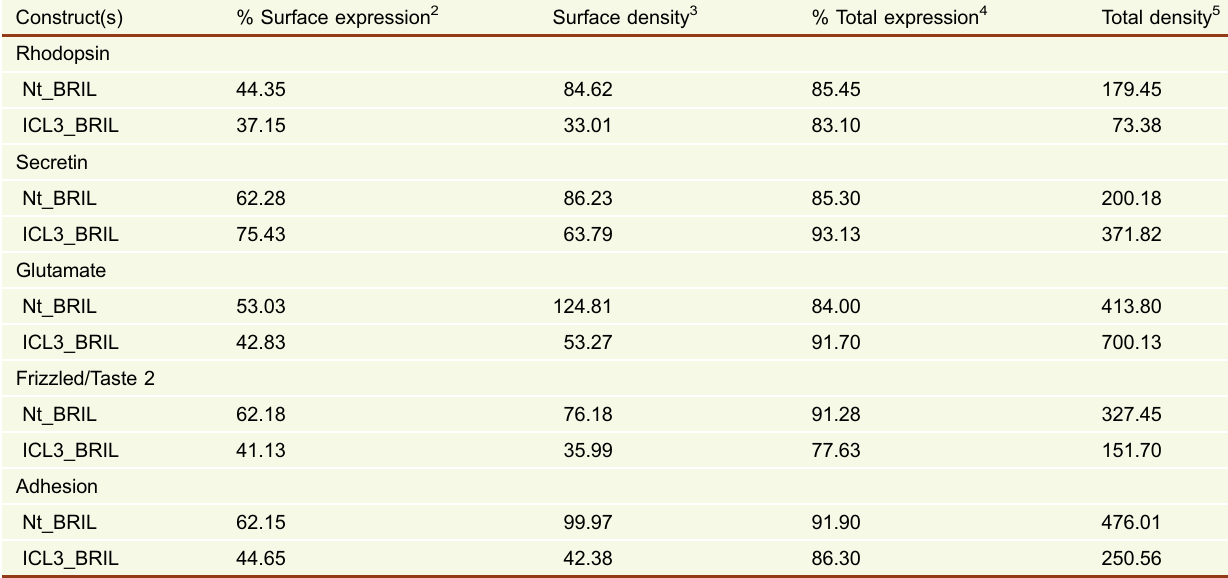
Table 5. Median expression levels by family and construct 1